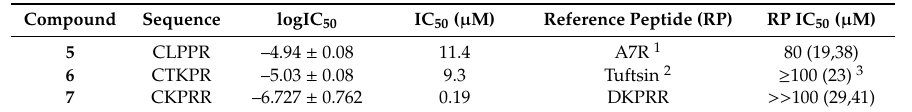
Figure 1. Superimposed chromatograms of peptides 3 ( A ) and 4 ( B ) incubated in PBS at 22 ◦ C for 0 h (black) and 4 h (red). Table 2. Inhibitory e ff ects of known peptidic ligands from the literature, modified by a Cys addition at the C-terminus, on the VEGF-A 165 / NRP-1 complex